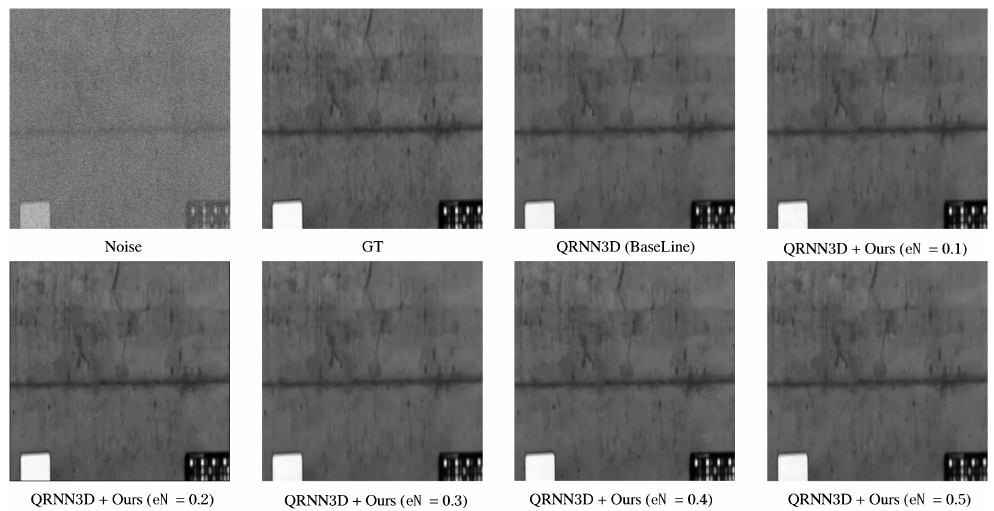
Figure 17. Comparison of the results for different patch-swap ratios.